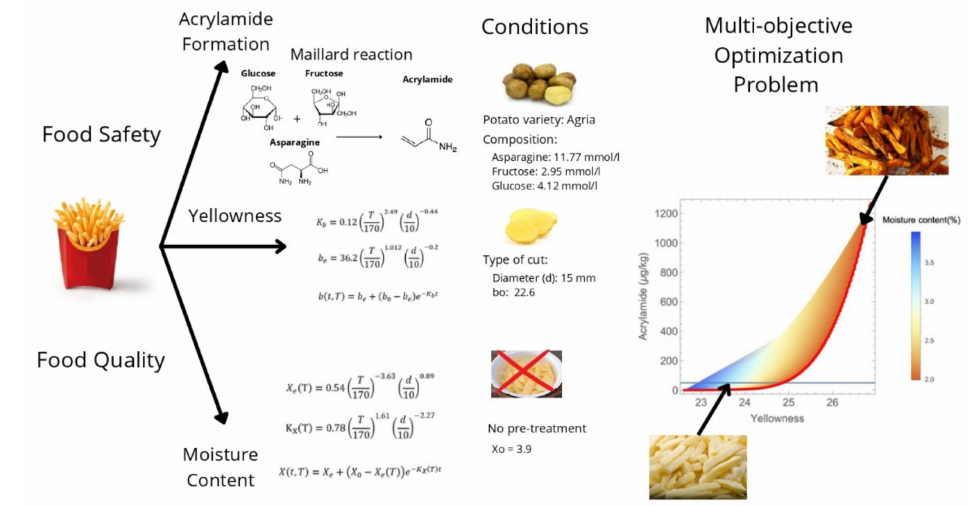
Figure 1. Outline of the case